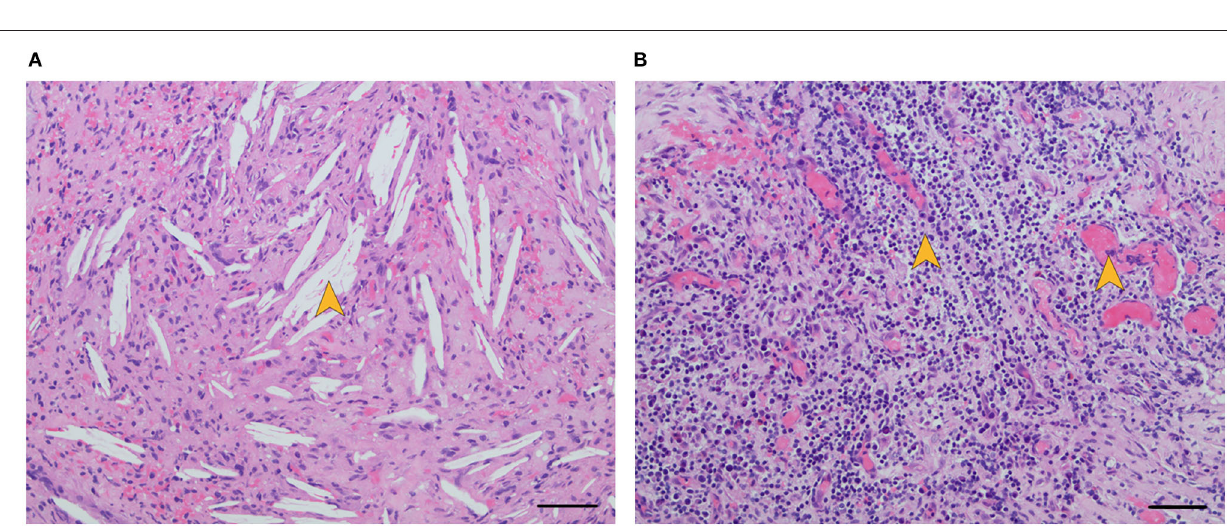
FIGURE 3 | H&E staining of biopsy specimen showed cholesterol clefts [ (A) , yellow arrow] and inflammatory granulation tissue formation [ (B) , yellow arrows] around fistulae. Scale bar, 50 µ m ( ×